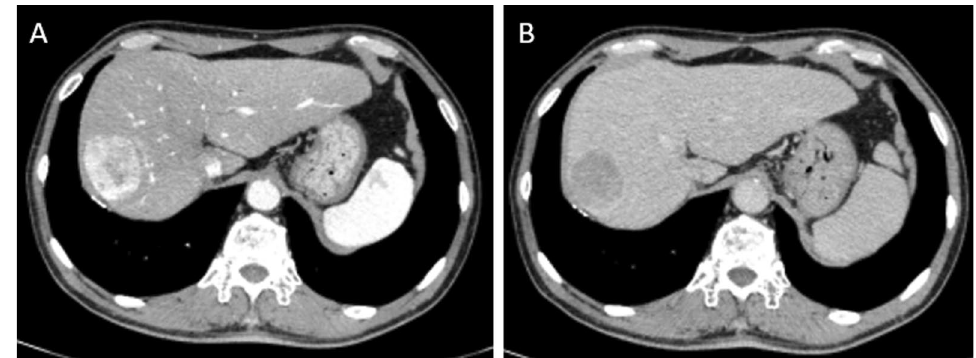
Fig. 1 Contrast-enhanced computed tomography findings (focused on tumor). A Early phase. B Delayed phase. A 40-mm tumor in segment 8 of the liver, which was enhanced in the early phase and washed out in the delayed phase, suggesting hepatocellular carcinoma